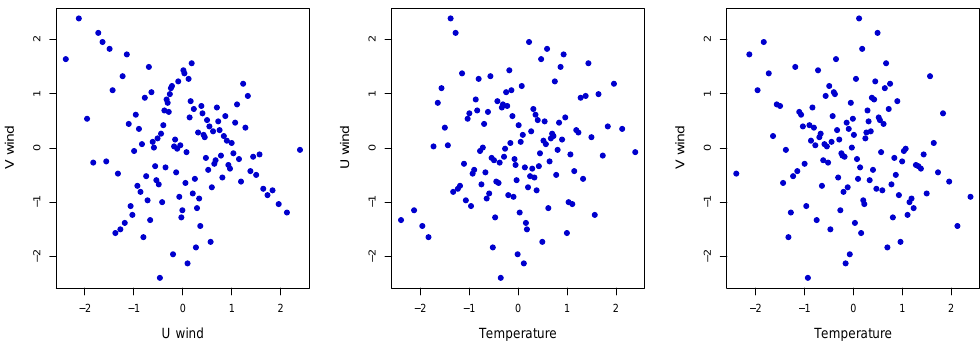
Figure 22. Normal scores of the errors between weather variables.